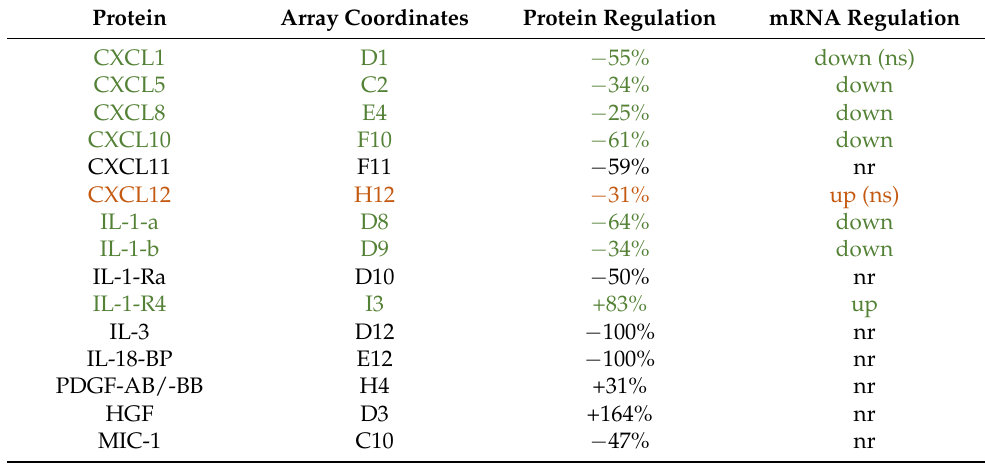
Table 3. List of differentially expressed proteins using a cytokine proteome